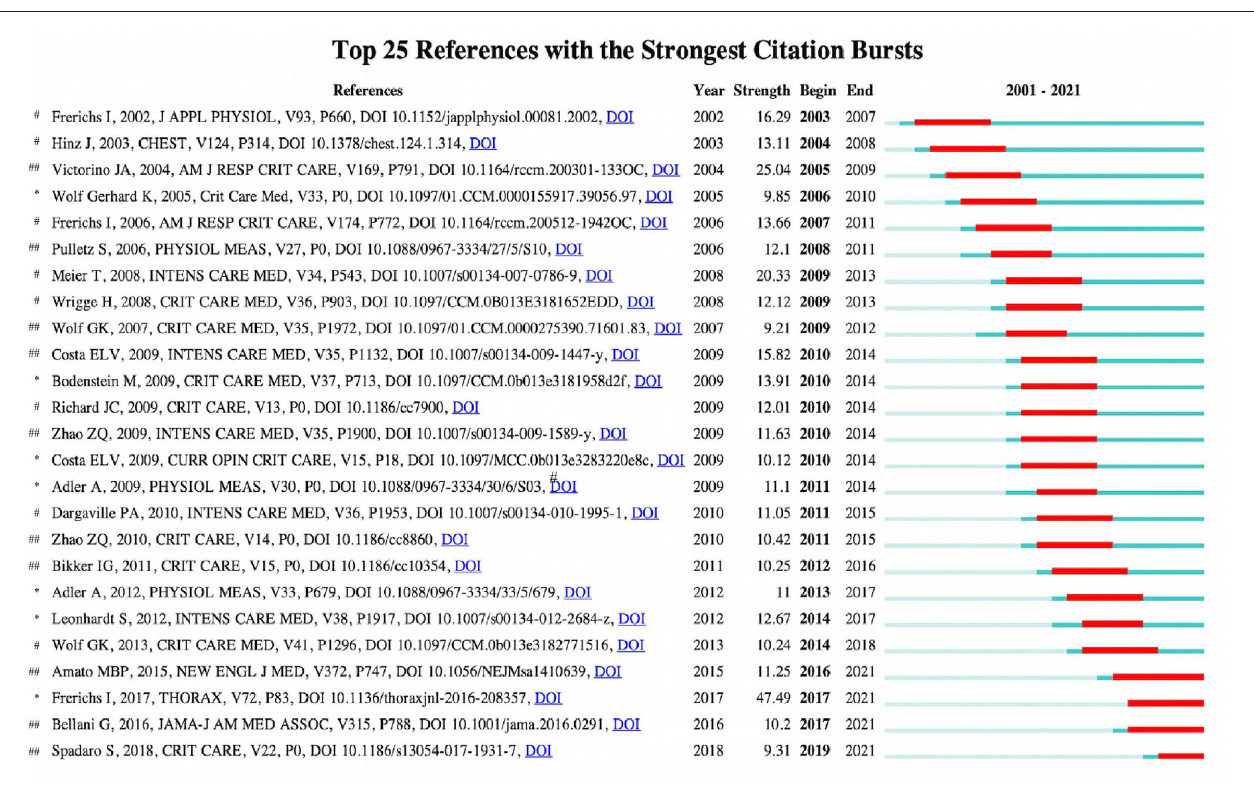
FIGURE 6 | The top 25 cited references with the strongest burst value on EIT applications in clinical lung monitoring research from 2001 to May 29, 2021. The dark blue bar indicated the years in which keywords slightly increased as a co-occurrence. In contrast, the red bar shows that co-occurrence rises sharply. *Review, # Animal research, and ## Clinical research.